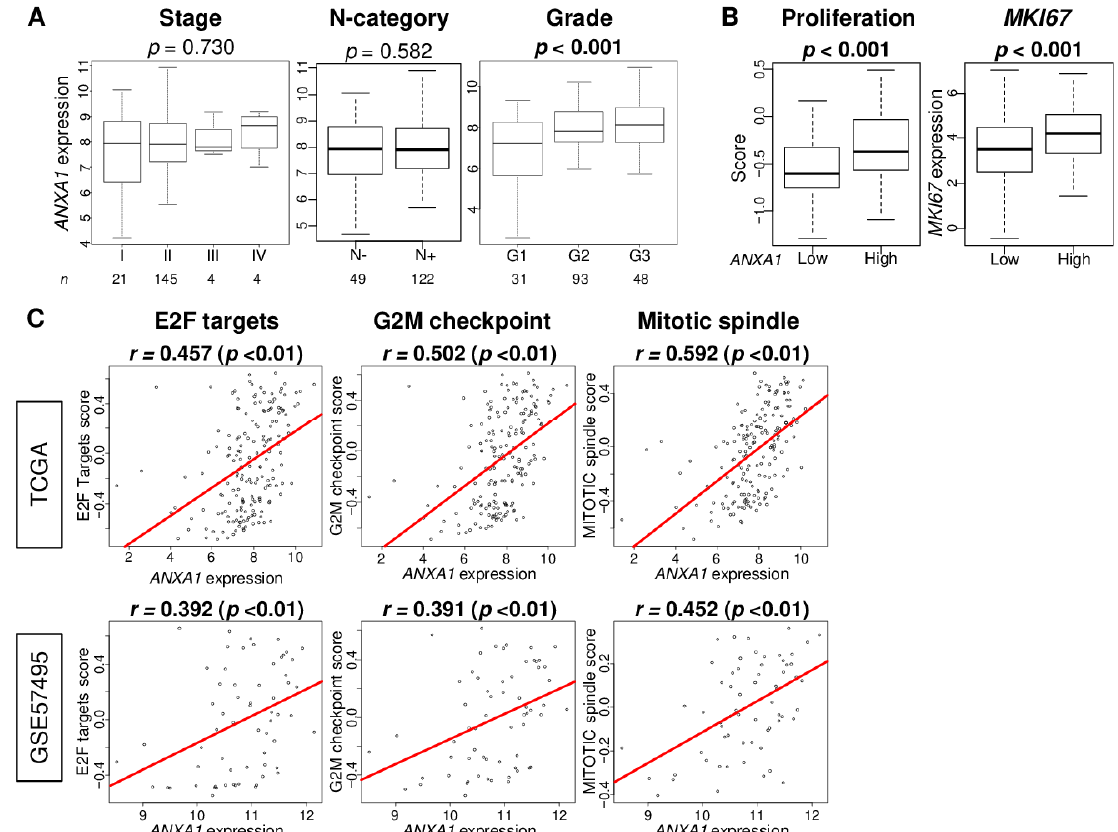
Figure 5. Association of the ANXA1 expression and tumor aggressiveness in PC. Boxplots of ( A ) the clinical factors: AJCC stage, N-category, and histological grade and ( B ) proliferation-related factors: proliferation score and MKI67 expression in the TCGA cohort. p -values were calculated by the Kruskal–Wallis and Mann–Whitney U tests. ( C ) Correlation plots between the ANXA1 expression and cell proliferation-related score: E2F targets, G2M checkpoint, and Mitotic spindle score in the TCGA and GSE57495 cohorts. The median cut-off was used to divide them into the ANXA1 low and ANXA1 high groups ( n = 88, respectively). Spearman’s rank correlation was used for the analysis. AJCC: American Joint Committee on Cancer.